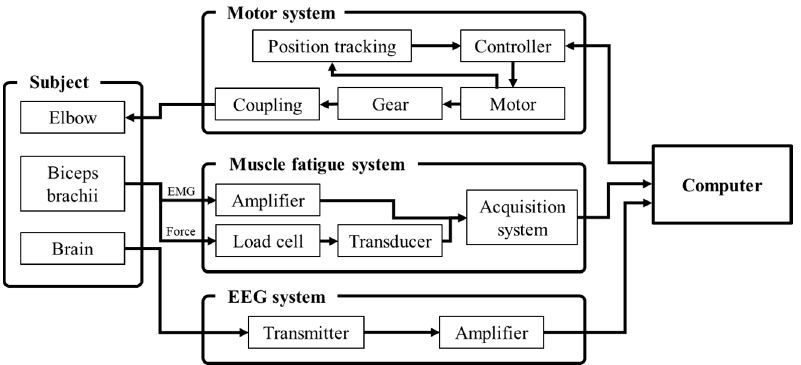
Figure 2. The continuous passive motion mirror therapy (CPM − MT) system overview.